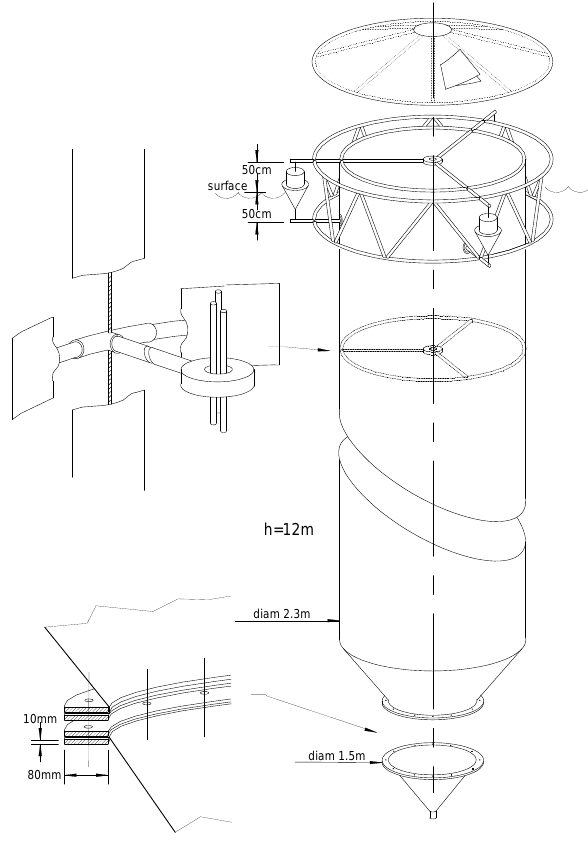
Fig. 8. Drawing representing the main features of the large-clean mesocosm device. The cone at the bottom is installed under water by two divers 24h after the top piece has been deployed from the surface: the two PVC sandwiches are joined with plastic screws.